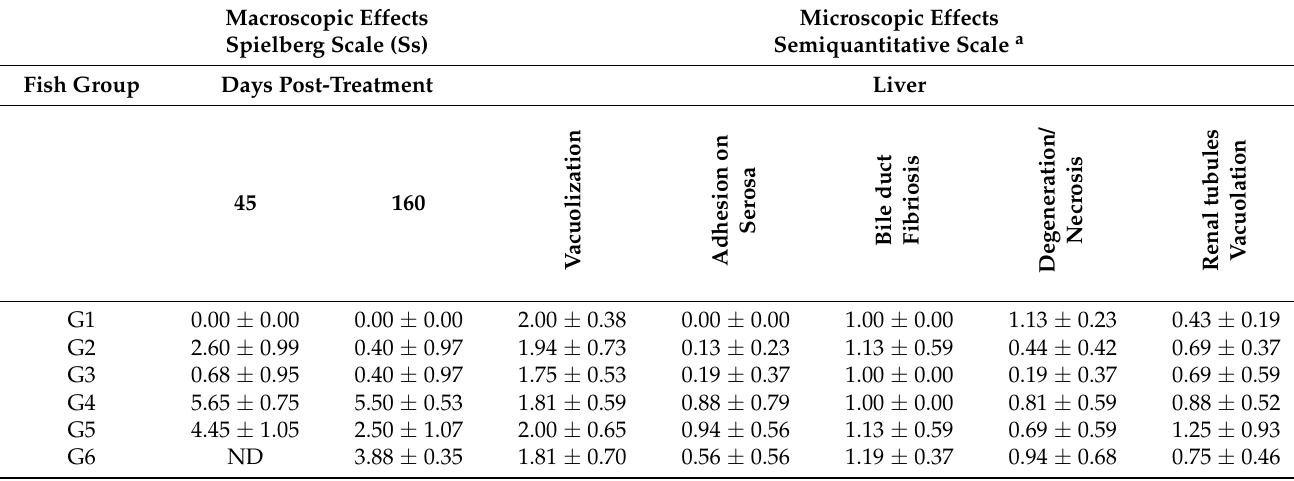
Table 1. Macroscopic and microscopic effects of fish after treatments. Results are presented as the mean ± standard deviation.